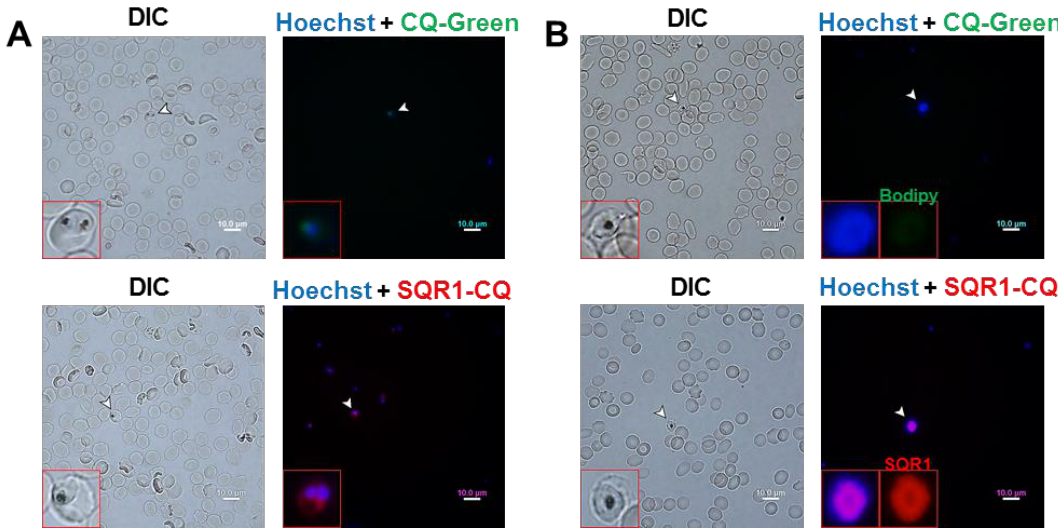
Figure 3. Comparison between CQ-Green and SQR1-CQ. Live 3D7 ( A ) mature trophozoites and ( B ) schizonts were co-labelled with Hoechst 33342 and either 2 µM CQ-Green or 1 µM SQR1-CQ, before analyzing via confocal microscopy on identical exposure and image capture settings. SQR1-CQ-labelled of 3D7 trophozoites and schizonts exhibited higher fluorescence than that of CQ-Green. Insets of trophozoites and schizonts indicated by arrowheads magnified at further 5×. Bar = 10 µm.